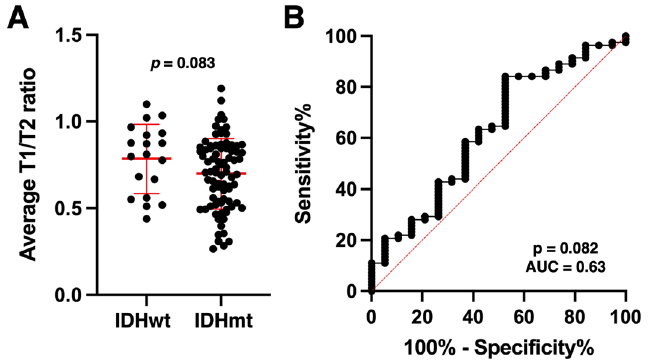
Figure 6. Revalidation of rT1/T2 cut-off for IDH mutation in the validation cohort 2 (study 3 using the international cohort from TICA/TCGA). There was no significant difference in mean rT1/T2 between the IDH- wildtype and IDH-mutant groups ( p = 0.083) ( A ). ROC curve for detecting IDH-mutant LrGGs shows AUC of 0.63, ( p = 0.082), with sensitivity of 42.9% and specificity of 73.7% ( B ).